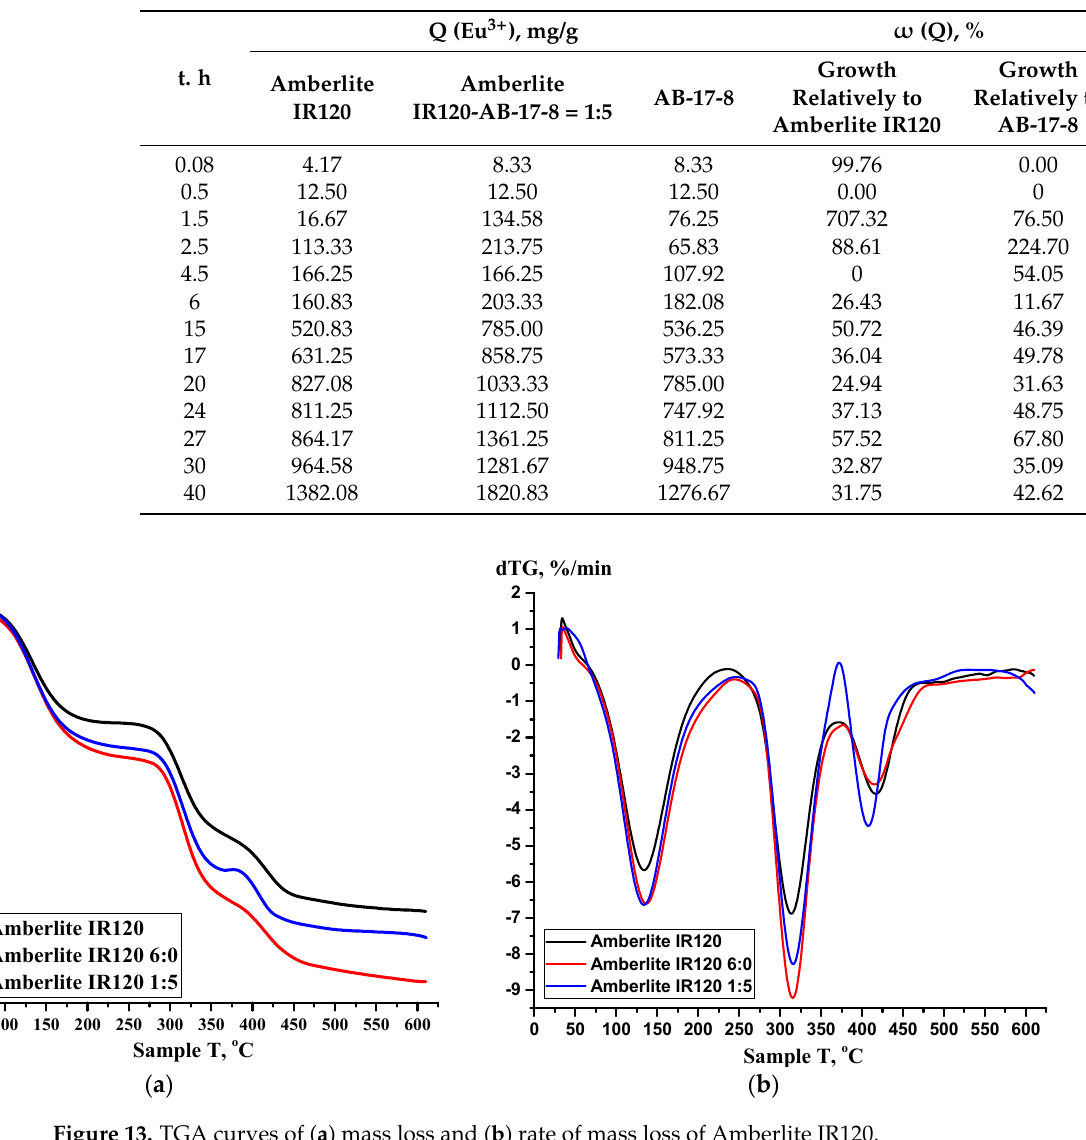
Table 6. Increase of effective dynamic exchange capacity in interpolymer pair Amberlite IR120:AB- 17-8 = 1:5 compared with individual ion exchangers.